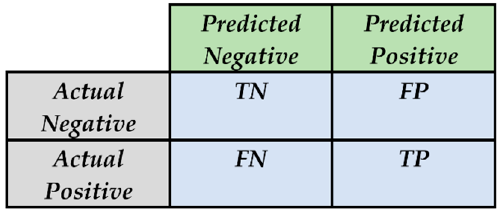
Figure 15. Confusion matrix for binary classification problem.